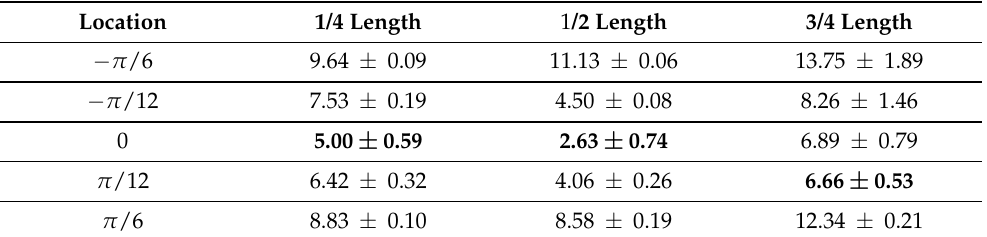
Table 2. Euclidean distances between the estimated and the real contact locations (expressed in millimetres).